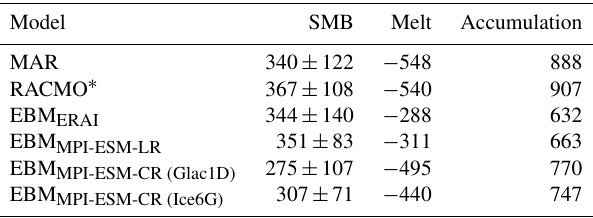
∗ RACMO data are provided on a slightly different topography with 1km horizontal resolution (see Noël et al., 2019, for details); the impact of the underlying topography on the SMB values is expected to be